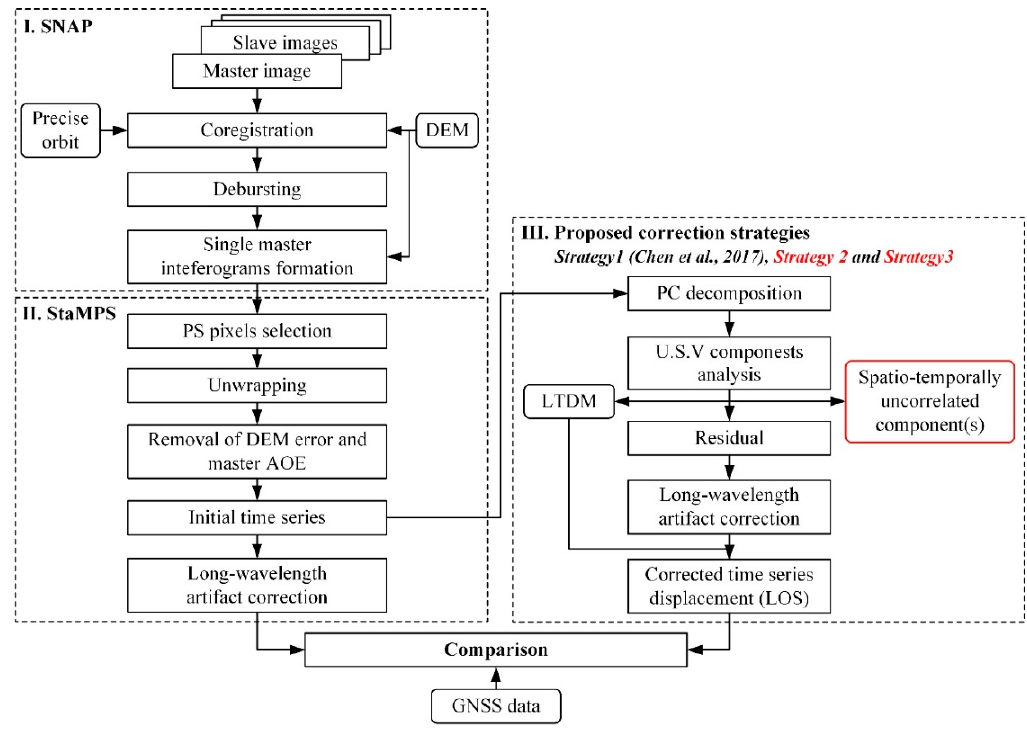
Figure 2. Flow chart of the data processing.